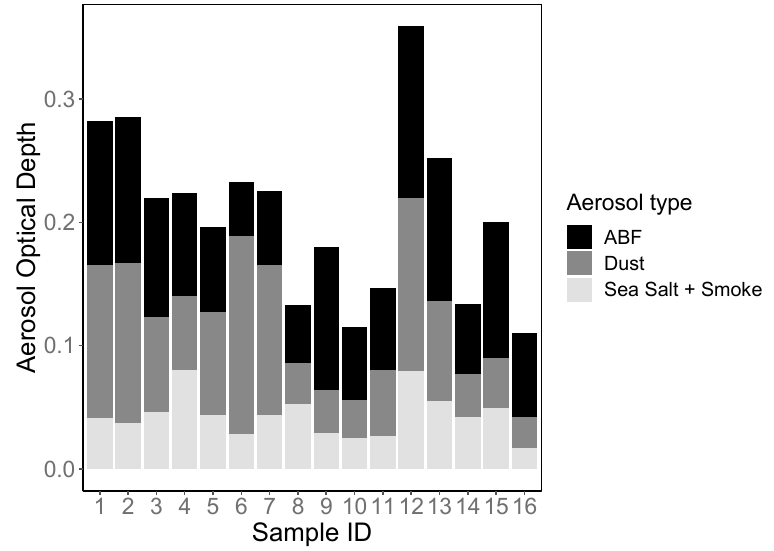
Figure 2. Aerosol optical depth (AOD) from Navy Aerosol Analysis and Prediction System (NAAPS) reanalysis at the time of collection at sample sites. Each bar represents one sample, with the height of each bar corresponding to total AOD. ABF (anthropogenic and biogenic fine aerosol species) in black, mineral dust in dark gray, and sea salt + and smoke in light gray, fractions of the total AOD are shown for each station.